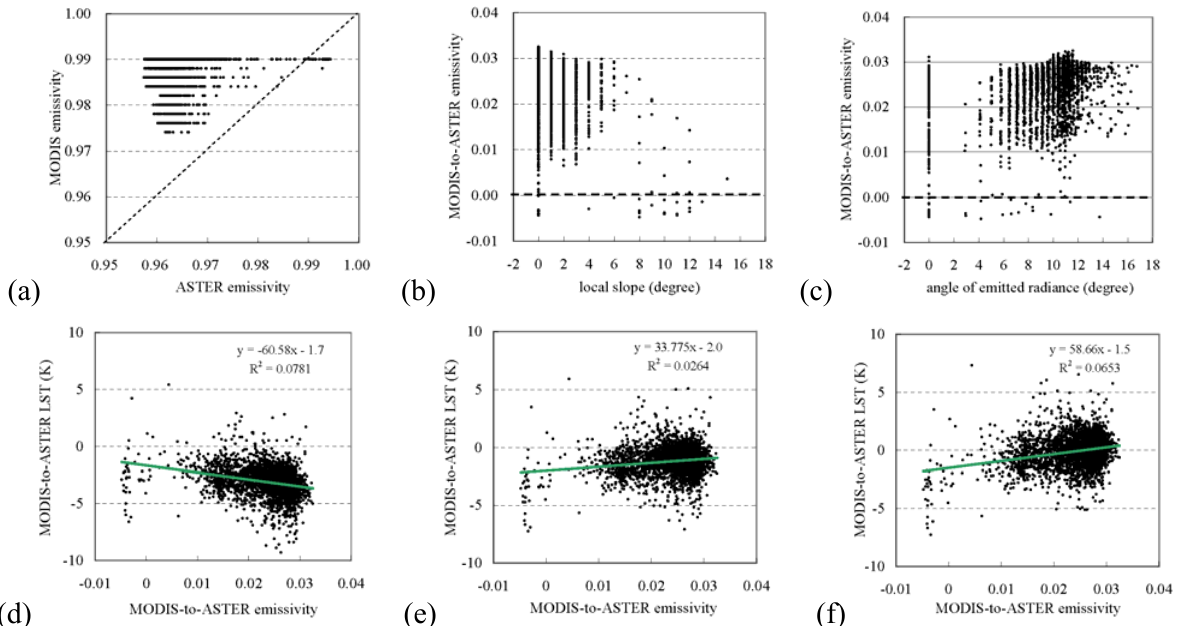
Figure 6 . (a) ASTER narrowband emissivity versus MODIS emissivity (band 31), (b) local slope versus ASTER-to-MODIS emissivity, (c) angle of emitted radiance versus ASTER- to-MODIS emissivity, (d) MODIS-to-ASTER emissivity versus LST without any correction, (e) MODIS-to-ASTER emissivity versus LST rectified with GSW based approach, and (f) MODIS-to-ASTER emissivity versus the rectified LST with terrain